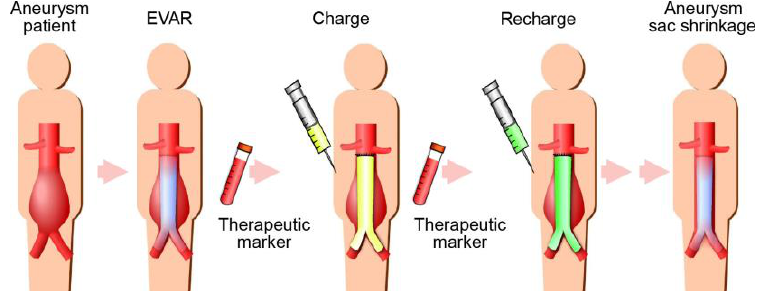
Figure 9. Schematic diagram of future directions for the novel hybrid drug delivery system. The system would enable the delivery of suitable drugs at aneurysms, based on a therapeutic marker when necessary. This system could serve as an adjuvant therapy to improve the long-term outcome of endovascular aneurysm repair (EVAR).